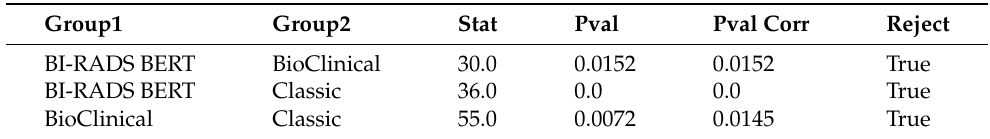
Table A11. Bonferonni-corrected McNemar test results for field extraction with no section segmenta- tion of previous cancer.